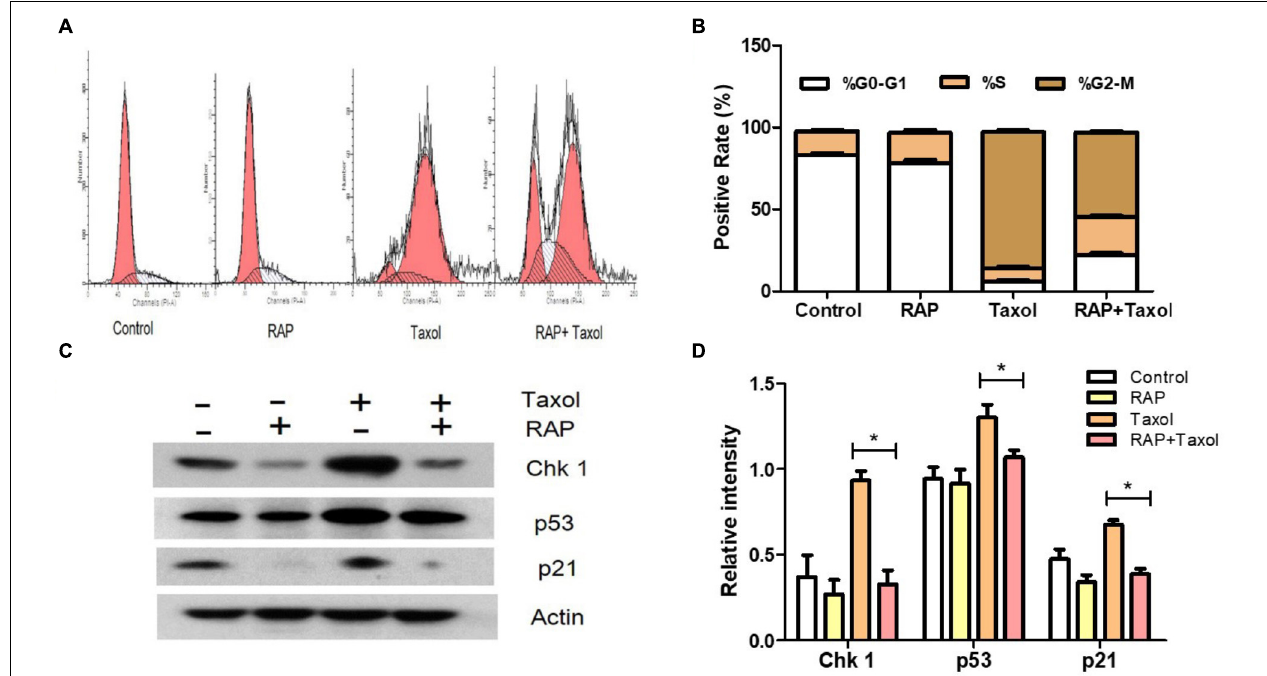
FIGURE 3 | G2/M cell cycle arrest and related proteins of RAW 264.7 cells treated by RAP (50 µ g/mL) with/without Taxol (10 µ M). (A) Diagram of cell cycle analysis in RAW 264.7 cells by flow cytometry; (B) Statistical analysis of G0-G1, S, and G2/M populations in RAW 264.7 cells; (C) Western blotting analysis of the level of phosphorylation of Chk1 (MW: 56 kDa), p53 (MW: 53 kDa), and p21 (MW: 21 kDa) protein expression; (D) Quantitative analysis of Chk 1, p53, and p21 ( ∗ p < 0.05 compared with Taxol alone group).